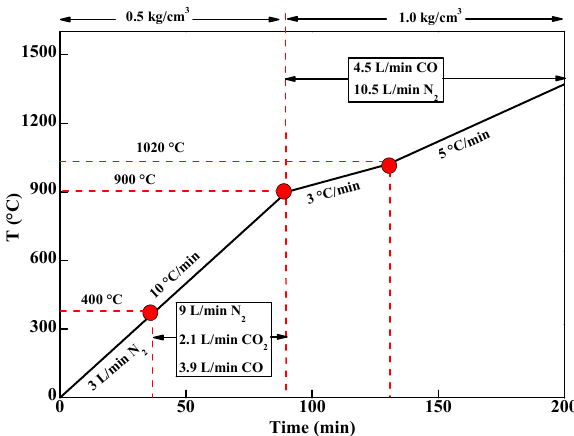
Figure 3. Experimental conditions for testing the melting properties.